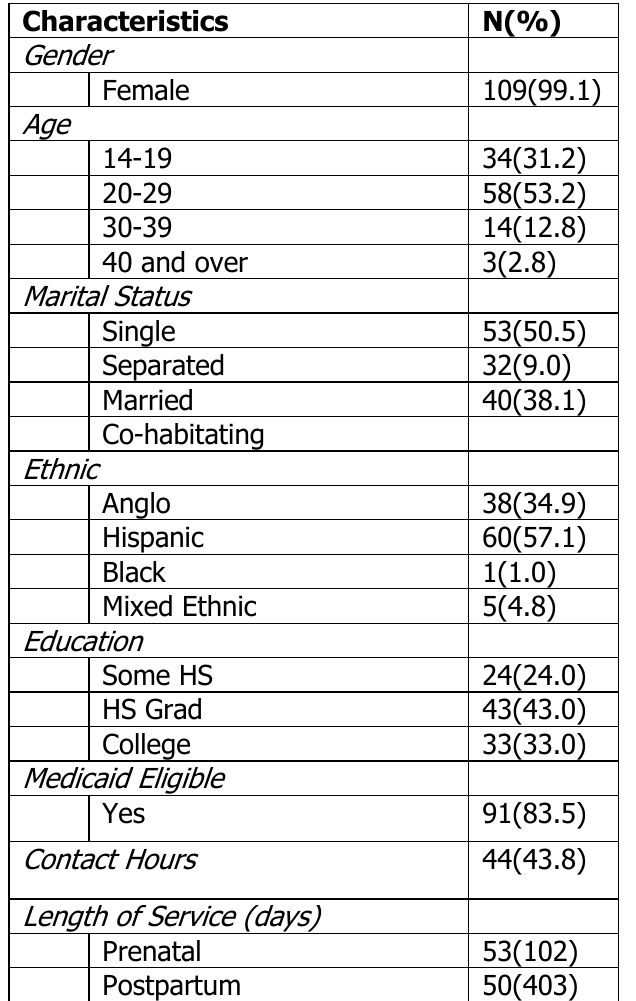
Characteristics of the 109 Subjects who enrolled in the First Born Program (FBP),